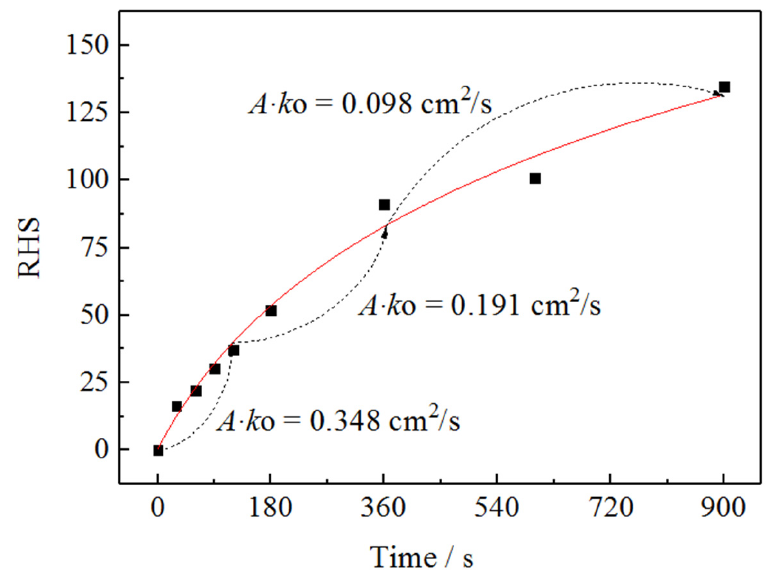
Figure 4. Relationship between RHS and time in Mori’s experiment (old model).